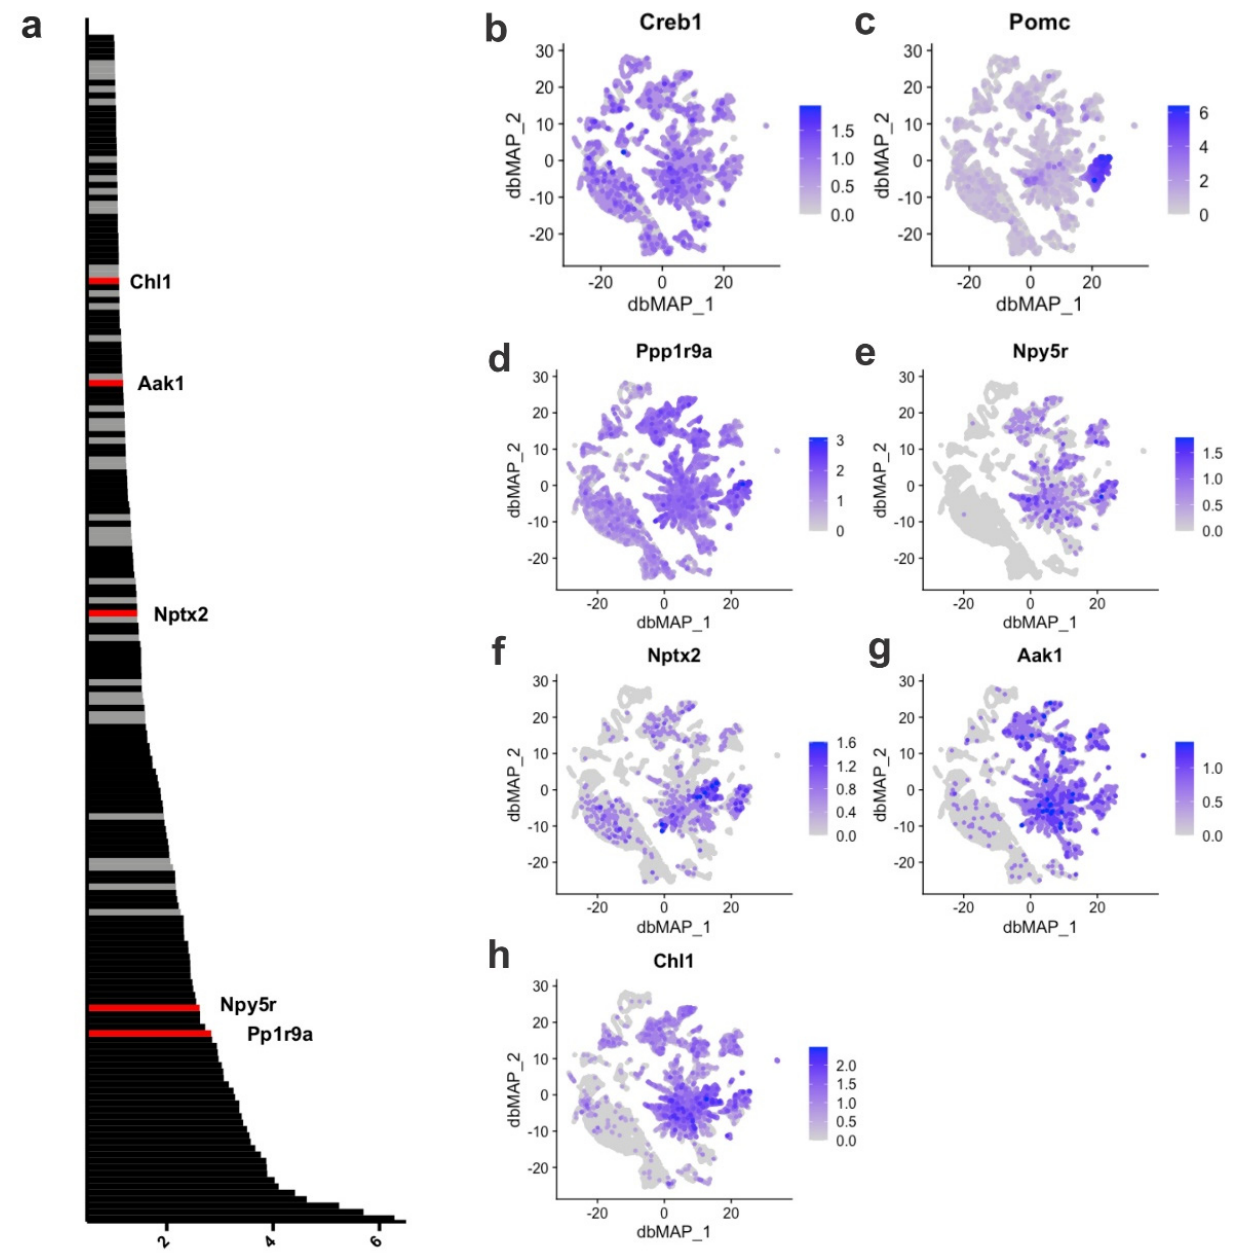
Figure 2. Creb1 transcriptional targets in the Arc-ME . ( a ) Relative importance scores for each of the 186 significant Creb1 transcriptional targets; ( b ) gene expression of Creb1 across cells in the Arc-ME; ( c ) gene expression of Pomc across cells in the Arc-ME. Based on their expression in Pomc-expressing cells, those with higher expression are highlighted in red and have their gene expression displayed beside: ( d ) Ppp1r9a ; ( e ) Npy5r ; ( f ) Nptx2 ; ( g ) Aak1 and ( h ) Chl1 . In contrast, those with lower/no expression in these cells have their scores represented in gray. Gene symbols, relative importance scores and functions are available in Supplementary Table S2.